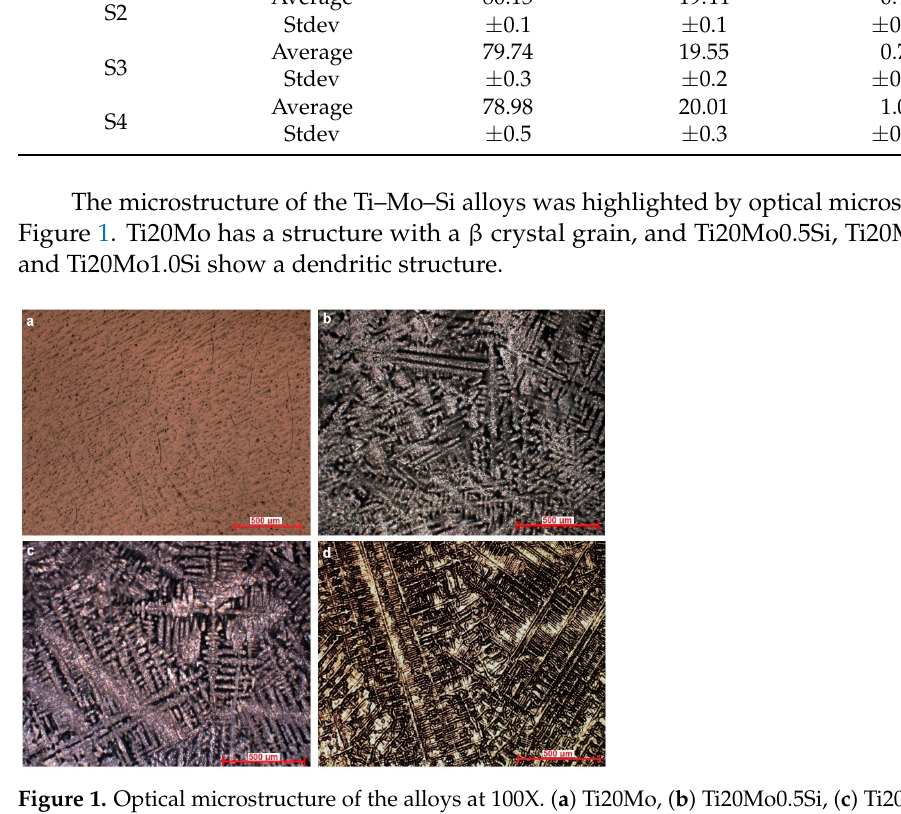
Figure 1. Optical microstructure of the alloys at 100X. ( a ) Ti20Mo, ( b ) Ti20Mo0.5Si, ( c ) Ti20Mo0.75Si, ( d )